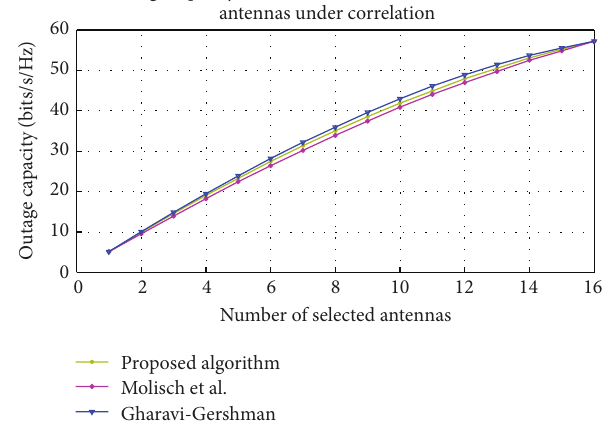
Figure 7: Plots showing variation of outage capacity with number of selected antennas for 𝑀 𝑇 = 16 and 𝑀 𝑅 = 16 under correlated